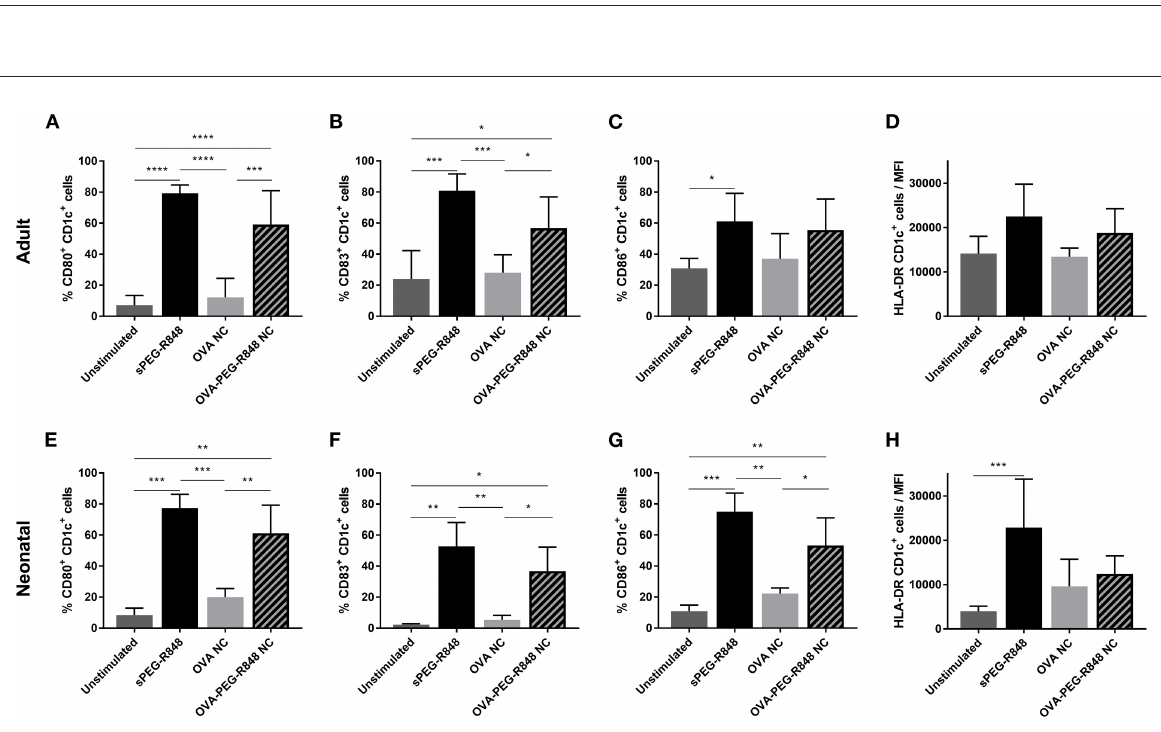
FIGURE5 Stimulation of CD1c + cDC2 by OVA-PEG-R848 NCs. Flow cytometric analysis of adult (A–D) and neonatal (E–H) CD1c + DCs after incubation with soluble PEG-R848, empty OVA NCs or OVA-PEG-R848 NCs. Frequency of CD80 + (A,E) , CD83 + (B,F) and CD86 + (C,G) cells as well as HLA-DR mean fluorescent intensity (D,H) was evaluated. Data represent the means ± SD [ (A–D) , n = 5; (E–H) , n = 3). Significantly different: * P < 0.05; ** P < 0.01; *** P < 0.005; **** P < 0.0001 (one-way